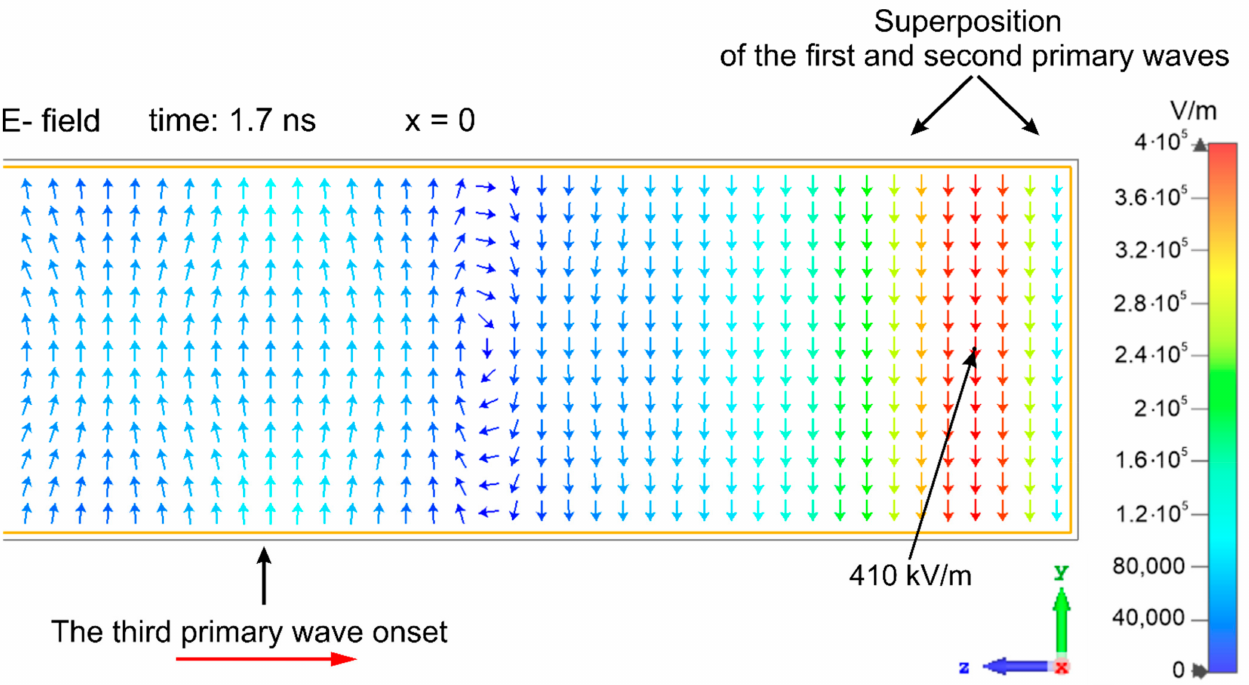
Figure 8. The electric field strength amplitude in the y–z plane for x = 0 at t = 0.54 ns, close to the rear wall, is shown. The figure shows the first interference of the waves P1 and P2 (for t = 1.7 ns). Retrieved from Figure 3Ek.